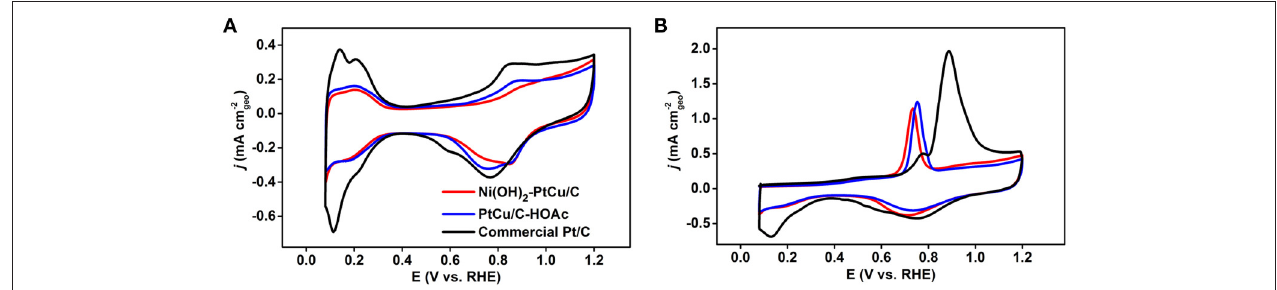
FIGURE 4 | (A) Cyclic voltammograms (CVs) and (B) CO stripping curves of the Ni(OH) 2 -PtCu/C, the PtCu/C-HOAc, and the commercial Pt/C recorded in 0.1M HClO 4 solutions with a scan rate of 50mV s − 1 at room